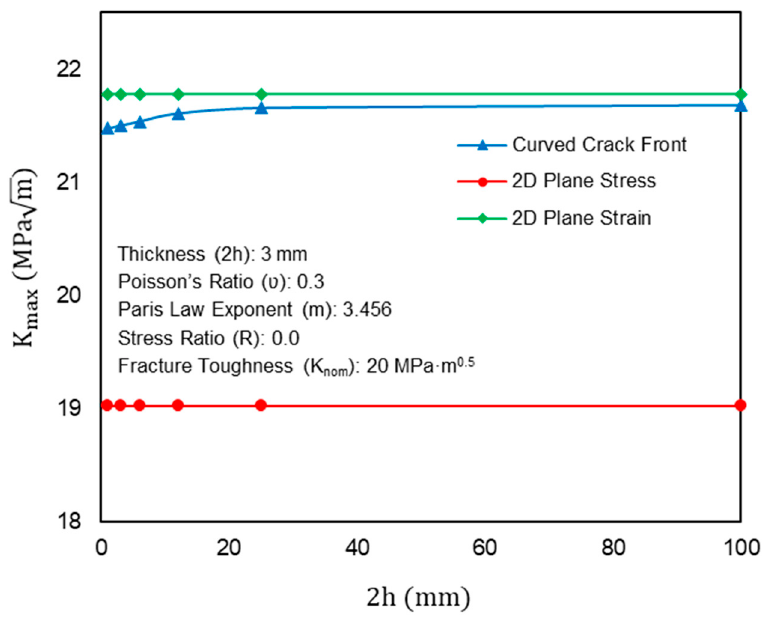
Figure 4. The effect of the thickness on the maximum stress intensity factor.